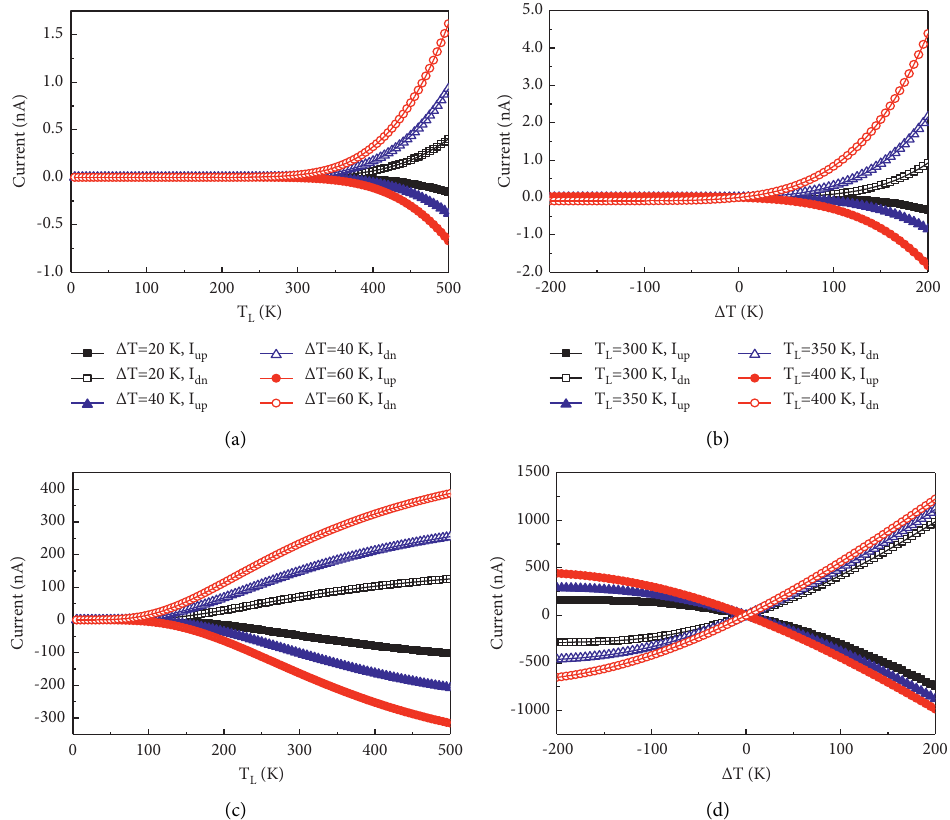
Figure 5: Spin-up currents ( I up ) and spin-down currents ( I dn ) in terms of T L for the N-ZKGNRs devices at selected temperature difference: (a) N � 4; (c) N � 21. I up and I dn in terms of ΔT for selected values of T L : (b) N � 4; (d) N �